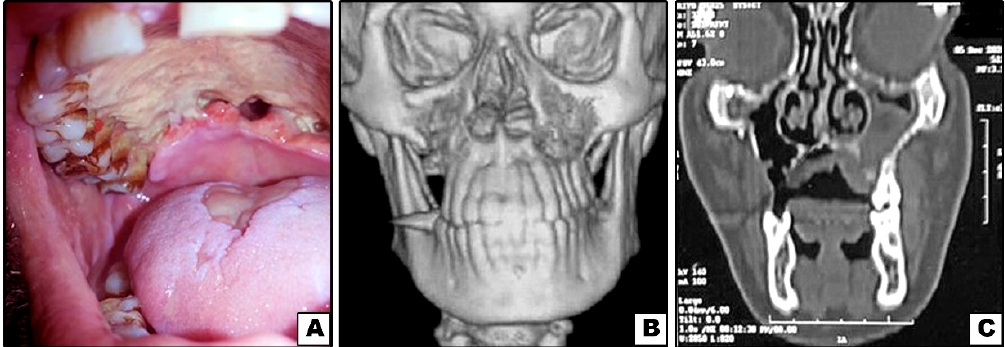
Figure 2. Case#3: ( A ) Exposed necrotic palatal bone with palatal perforations. ( B , C ) 3D and coronal CT showing bone destruction of right and left maxillae (not involving inferior orbital rims).